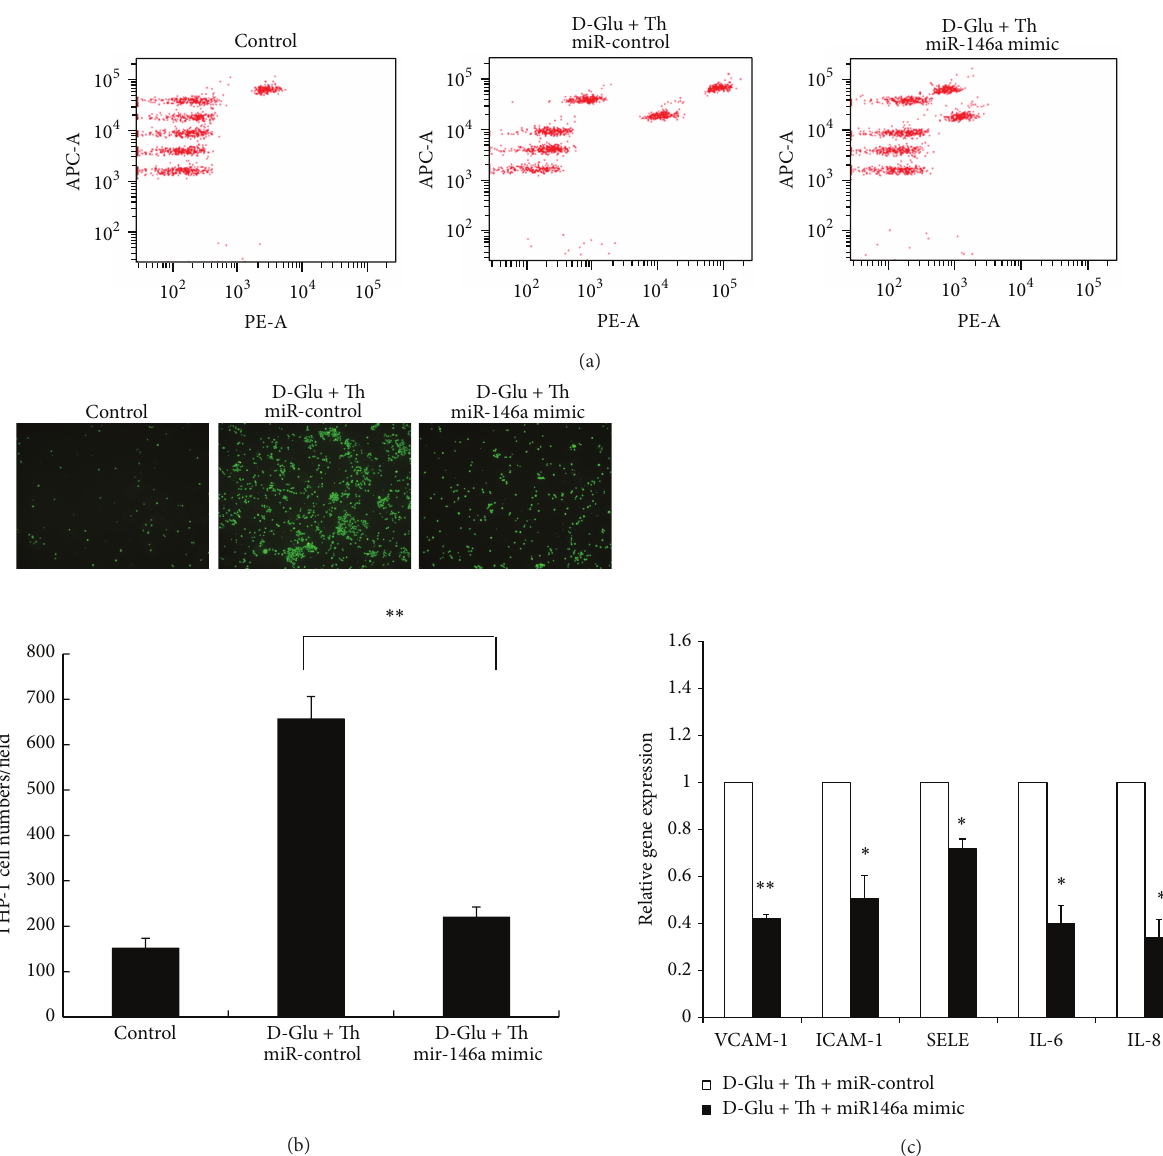
Figure 6: The proinflammatory phenotypes of HG/thrombin-stimulated HAECs were attenuated by a miR-146a mimic. (a) Analysis using an inflammatory cytokine kit showed that the stimulatory effect of HG/thrombin on IL-8 and IL-6 protein expression in conditioned mediums was preserved in miR-control-transfected HAECs, while the stimulatory effect was attenuated in miR-146a mimic-transfected, HG/thrombin- stimulated HAECs. The images shown represent the results from 3 independent experiments. (b) The stimulatory effect of HG/thrombin on THP-1 adhesion to HAECs was preserved in miR-control-transfected HAECs, while the THP-1 adhesiveness was attenuated in miR-146a mimic-transfected, HG/thrombin-stimulated HAECs to 34% of that in the miR-control-transfected HACEs. The bars represent the means ± SEM from 4 experiments. ∗∗ 𝑃 < 0.01 , as compared with the miR-control. (c) The stimulatory effect of HG/thrombin on the gene expression of VCAM-1 , ICAM-1 , SELE , IL-6 , and IL-8 significantly decreased in miR-146a mimic-transfected, HG/thrombin-stimulated HAECs to 42%, 51%, 71%, 40%, and 34% of that in miR-control-transfected, HG/thrombin-stimulated HAECs. The bars represent the means ± SEM from 3 experiments. ∗ 𝑃 < 0.05 and ∗∗ 𝑃 < 0.01 , as compared with the miR-control.